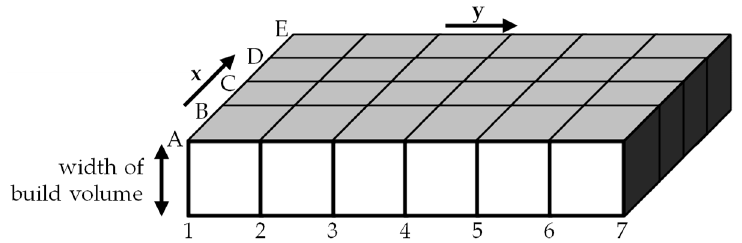
Figure 6. Cubic volume for the segmentation of